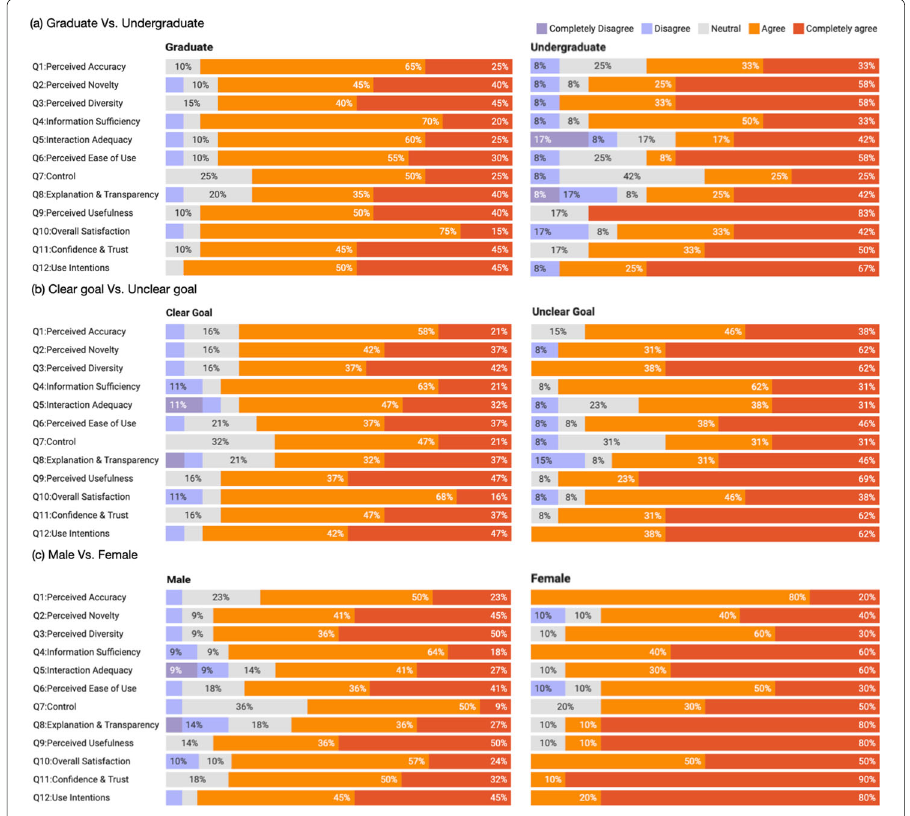
Fig. 8 Questionnaire results: a Graduate vs. undergraduate. b Clear goal vs. unclear goal. c Male vs.